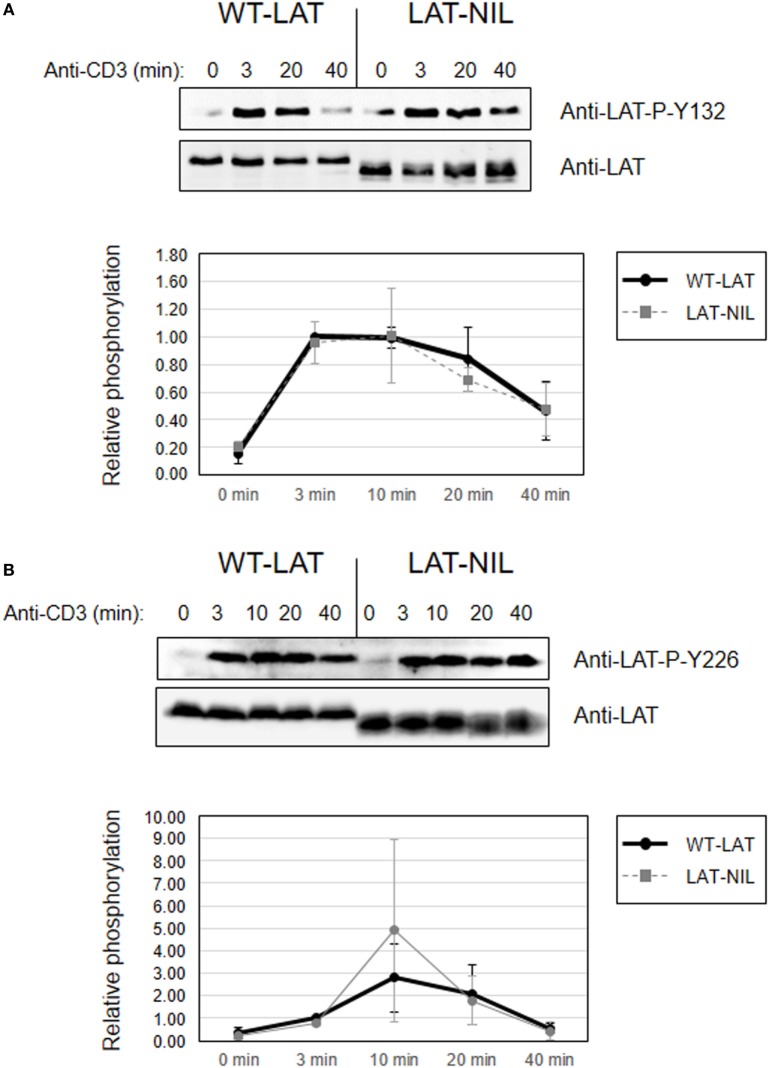
Phosphorylation of linker for activation of T-cell (LAT) tyrosines 132 and 226. Phosphorylation of LAT at tyrosine residues 132 (A) or 226 (B) in WT-LAT or LAT-NIL expressing cells. Membranes were stripped and blotted with anti-LAT antibody (middle panels). Lower diagrams represent the mean fold increase in phosphorylation in three independent experiments using J.CaM2 cells expressing WT-LAT (thick continuous line) or the LAT-NIL mutant (thin dashed line). Phosphorylation levels were normalized to total LAT expression.